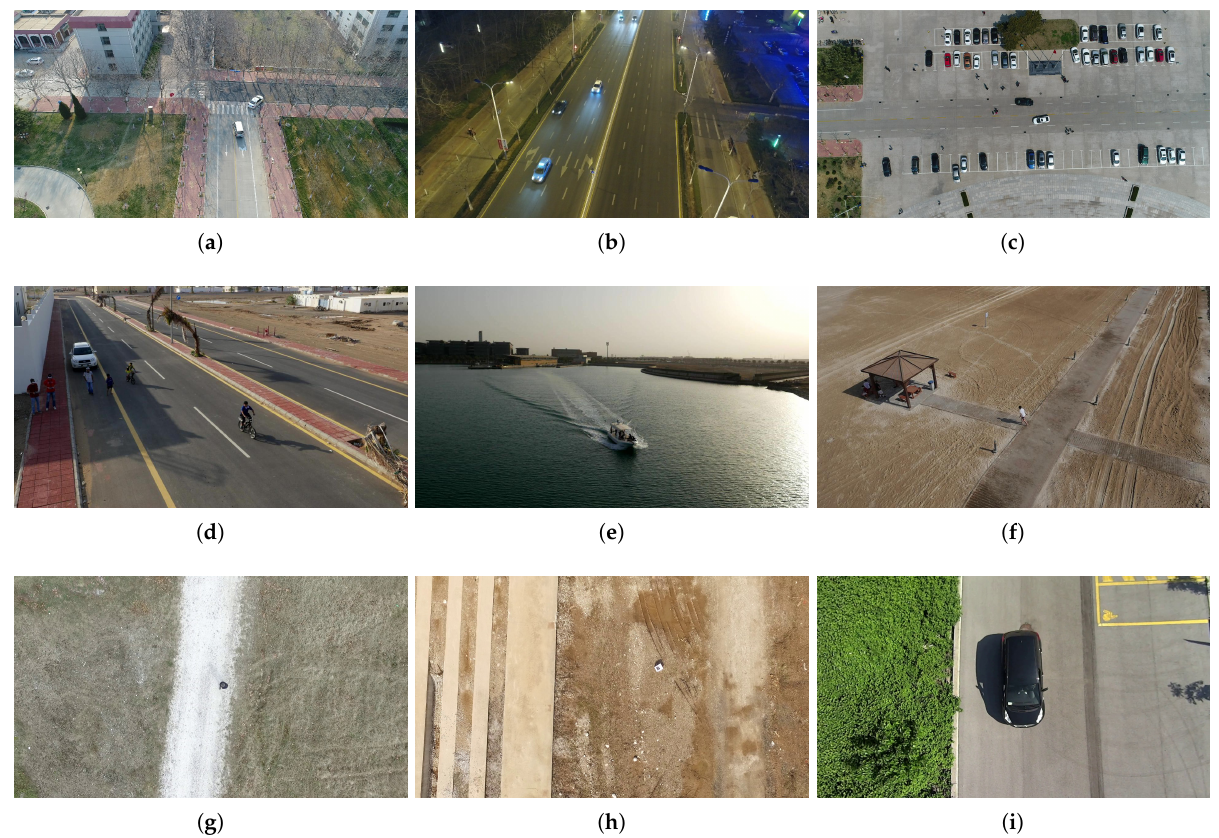
Figure 6. Example images from the used datasets. The first row depicts 3 cases from UAVDT datasets, namely, a daylight urban shot ( a ), a night urban shot ( b ), and a daylight urban shot with Nadir view ( c ). The second row shows 3 examples from UAV123/20L, namely, a daylight urban shot ( d ), a daylight shot over the sea ( e ), and a daylight shot in dirt environment ( f ). Finally, the last row depicts 3 images from the UMCD dataset acquired with a Nadir view in different environments, namely, countryside ( g ), dirt ( h ), and urban ( i